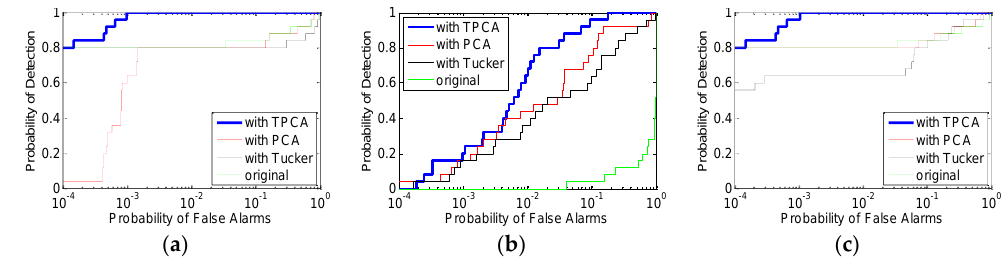
Figure 9. ROC curves with different feature extraction methods: ( a ) CEM; ( b ) ACE; and ( c ) AMF.